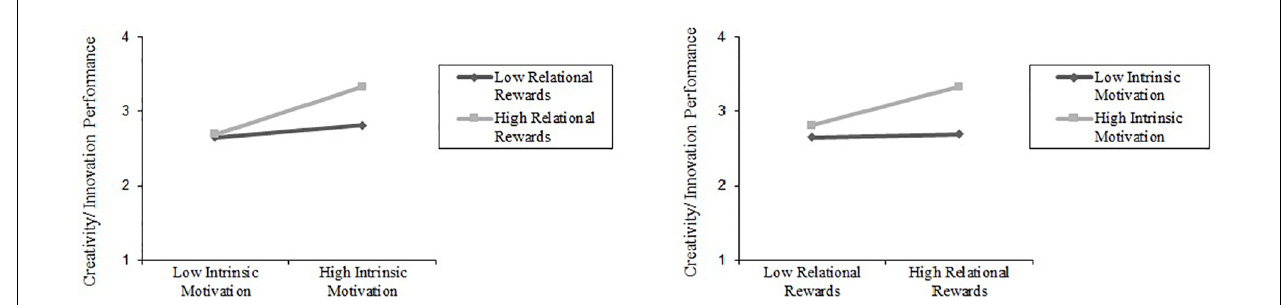
FIGURE 5 | Interaction effects of intrinsic motivation and relational rewards on creativity/innovation performance.